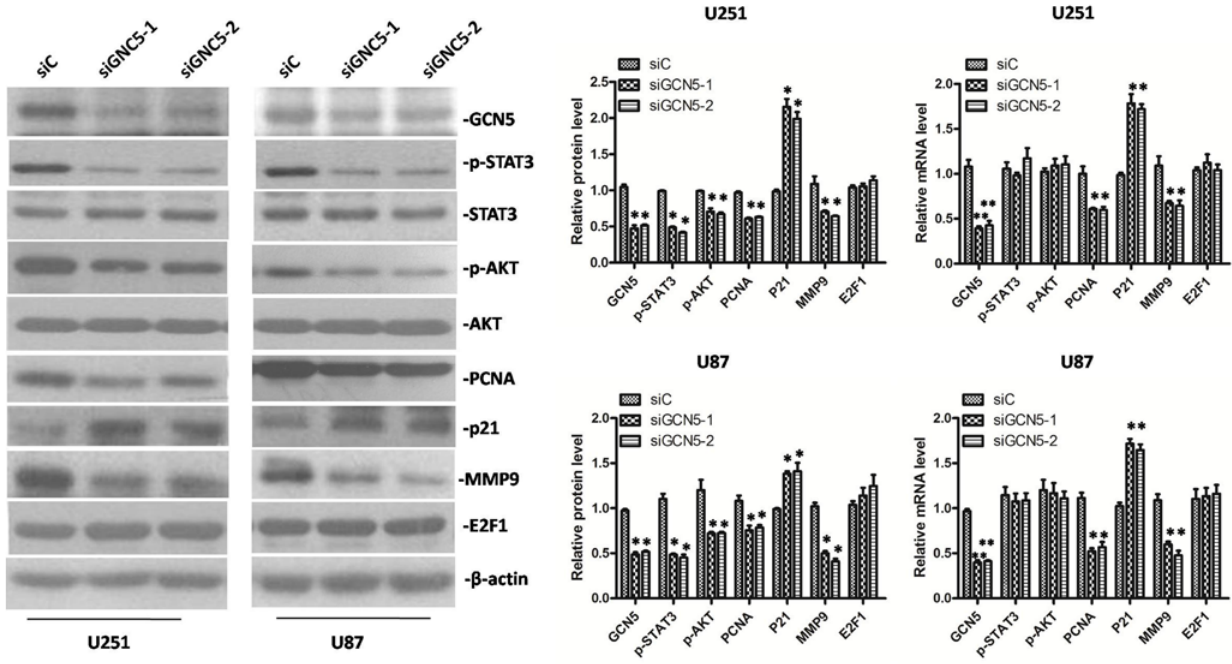
Figure 6. GCN5 knockdown decreased the expression of p-STAT3, p-AKT, PCNA, and MMP9 and increased the expression of p21 in glioma cells (* p < 0.05; ** p <